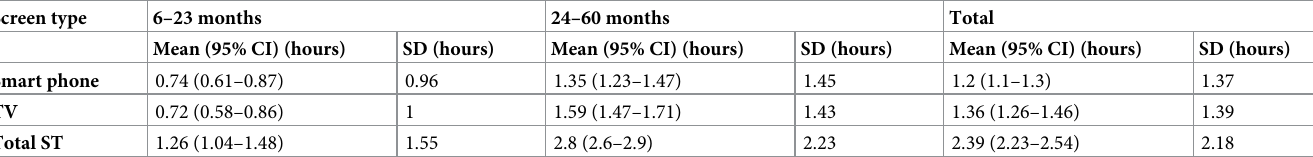
Table 2. Details of screen